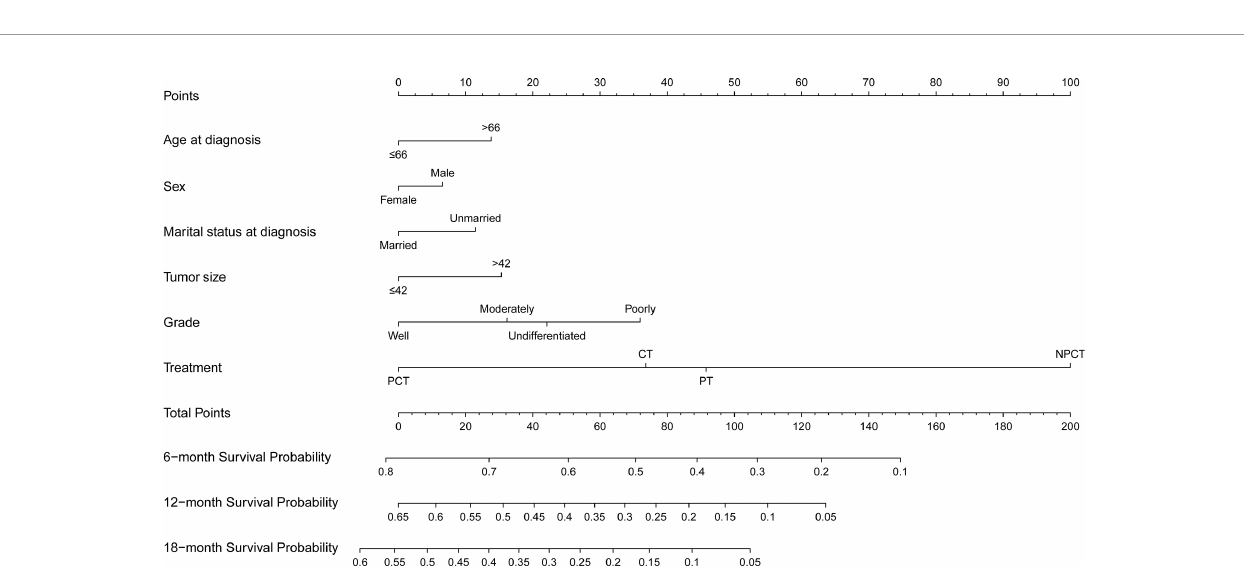
FIGURE 5 | Prognosis nomogram predicting 6 ‐ , 12 ‐ , and 18 ‐ month survival probability for patients with metastatic pancreatic cancer using six clinical characteristics.